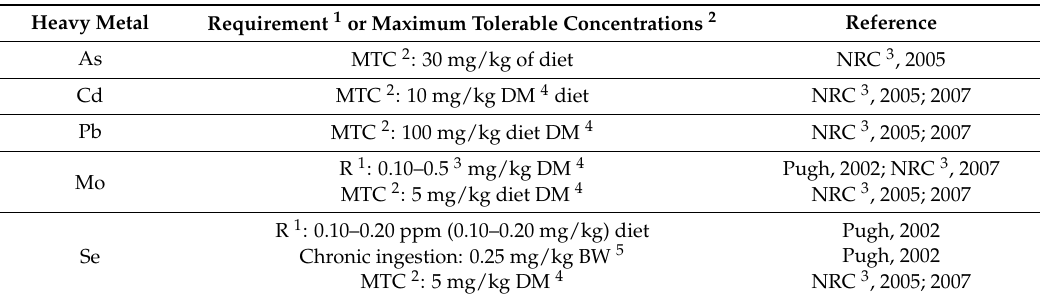
Table 2. Sheep dietary requirements and/or maximum tolerable